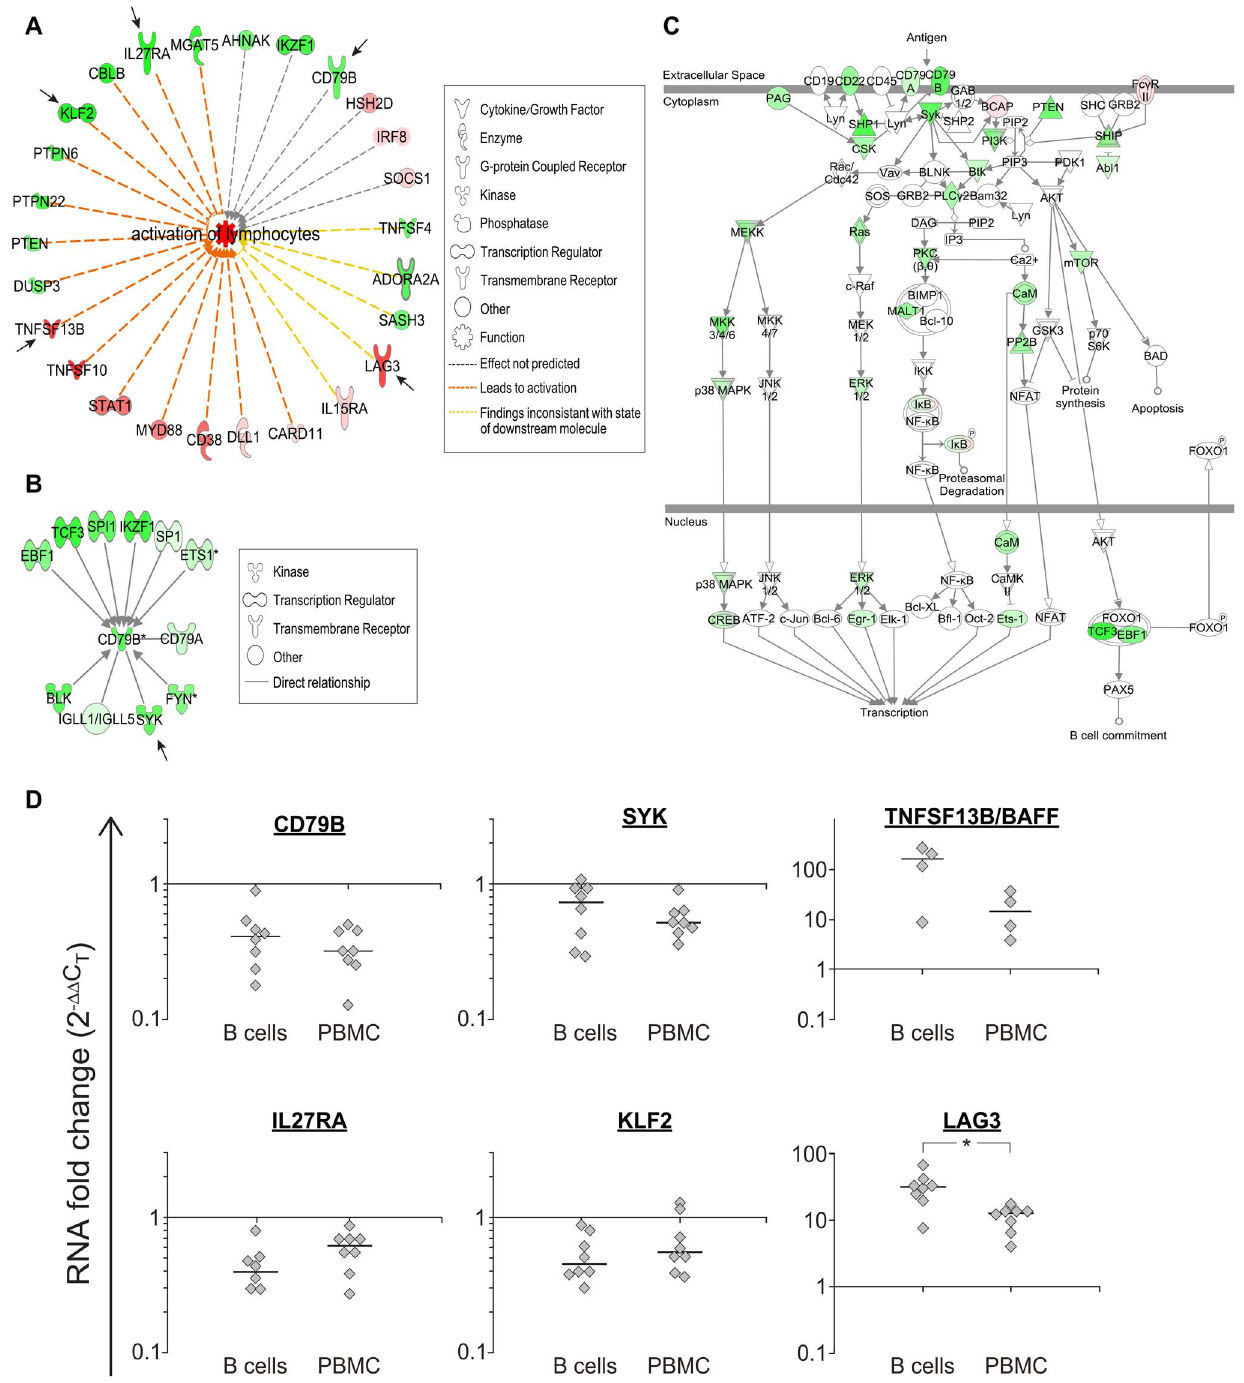
Figure 7. Networks of B cell-related genes are affected by IFN- b in LCLs. Network of genes included in the ‘Activation of Lymphocytes’ function highlighted by Ingenuity analysis (Z=2.33). Arrows points to IFN- b response genes that are not included in the Interferome database, and were included in a follow up validation analysis by quantitative RTPCR shown in D. In green- down-regulated genes; in red- up-regulated genes, color intensity is proportional to the fold change in expression levels following IFN- b exposure. A: An interaction network of CD79B, the immunoglobulin- b subunit of the B cell receptor signaling complex, with its regulators and interacting genes. The interacting nodes were limited to genes that were included in the filtered gene expression dataset, and were identified as directly connected to CD79B based on Ingenuity pathways analysis database. Notably, all the genes included in this network were found to be down-regulated by IFN- b (green) to some extent. Fold change and P-values are noted below each node. B: Decreased expression levels were observed for many of the genes included in the canonical B cell receptor signaling pathway in response to IFN- b . C: Quantitative reverse transcriptase RTPCR analysis of IFN- b response in primary B cells and PBMCs for genes marked in arrows in A and B. Genes were selected for validation because they were not identified by the Interferome database as IFN- b response genes, and are related to B cell function ( CD79B, SYK, TNFSF13B/BAFF ), or participate in the antimicrobial pathway depicted in Fig. 6 ( IL27RA ), or are related to activation of lymphocytes ( LAG3, KLF2 ). * P-value=0.007 (Mann Whitney test). doi:10.1371/journal.pone.0102331.g007 PLOS ONE |